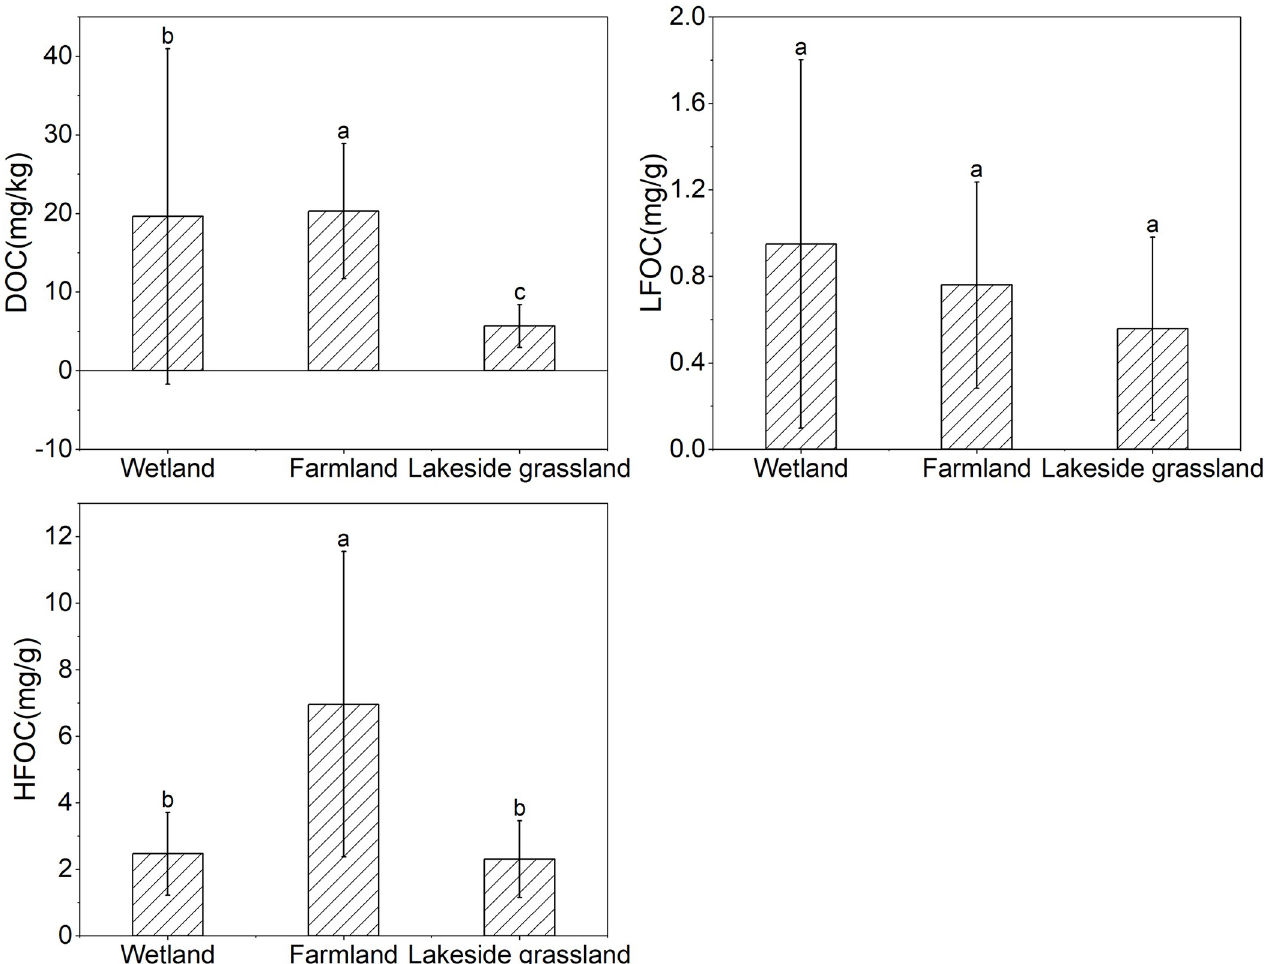
Fig 2. SOC content in different habitats. Error bars represent standard deviation of the mean (n = 5). DOC: dissolved organic carbon; LFOC: light fraction organic carbon; HFOC: heavy fraction organic carbon. Different lowercase letters indicate significant differences ( p <